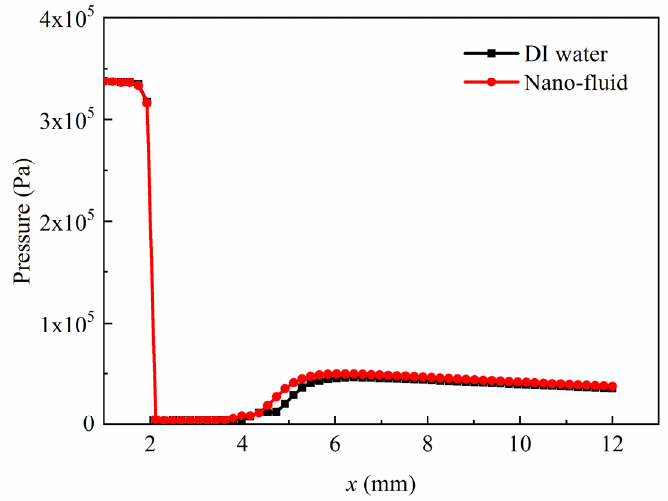
Figure 7. The pressure distributions along centerline on the symmetry plane.